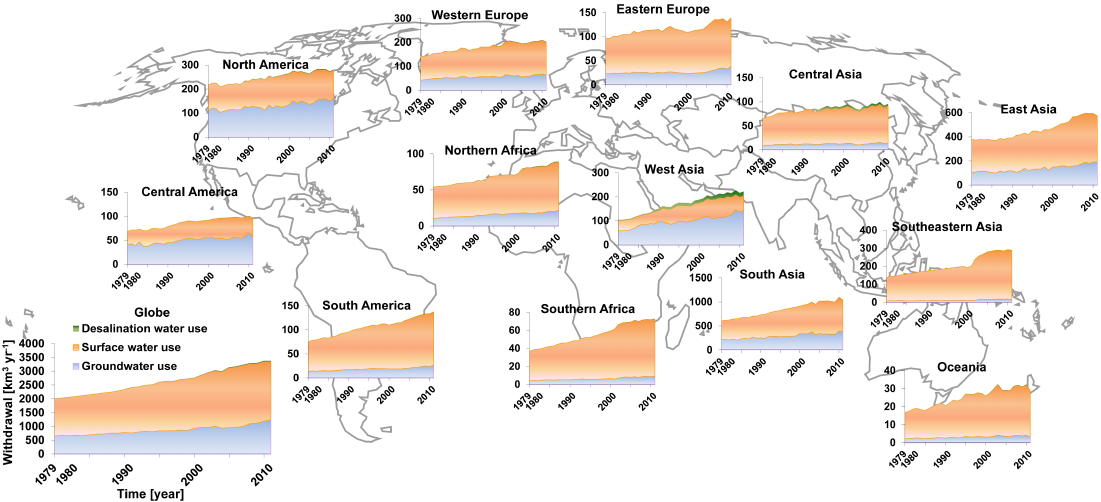
Fig. 5. Regional trends of water withdrawal per source (desalination water, surface water, and groundwater) over the period 1979–2010. The results were obtained from the mean of the simulation with the ERA-Interim and MERRA climate. The global figure is shown in the left corner.